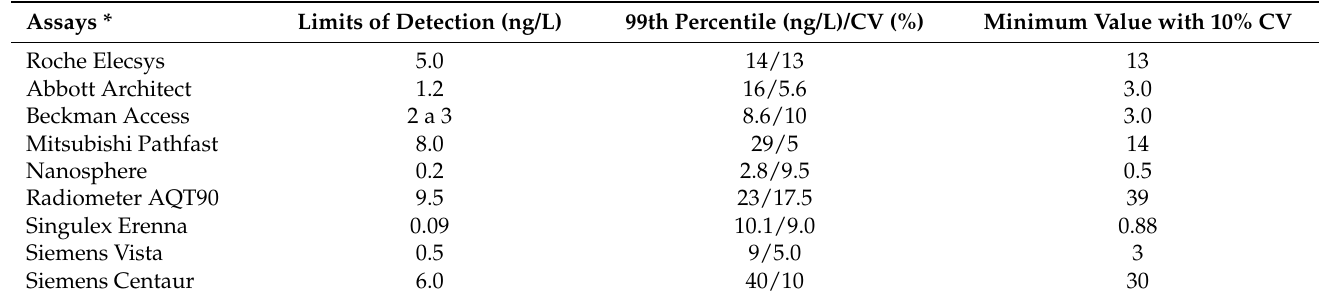
Table 8. Analytical comparison of contemporary and high-sensitivity cTnI